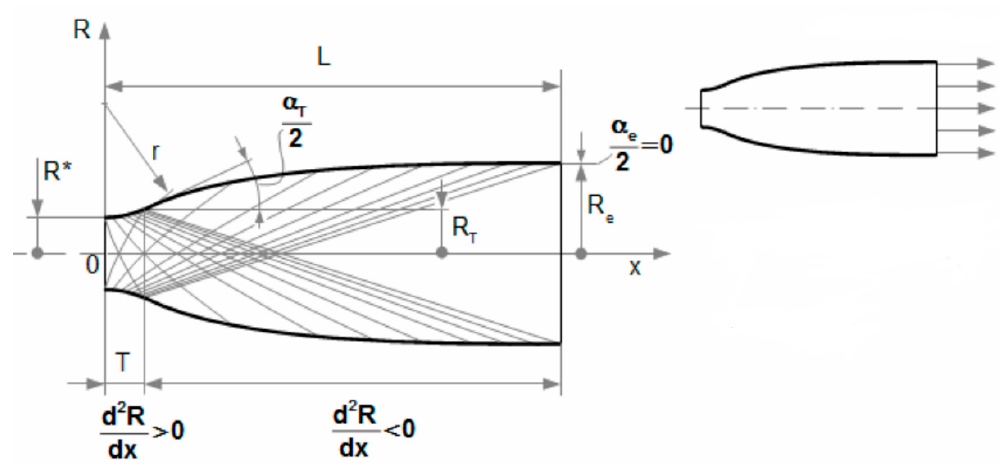
Figure 6. Laval nozzle—characteristic method. Reprinted from ref. [26]. Figure 7. Laval nozzle—Bell nozzle. Reprinted from ref. [26]. (cid:3436)𝑑𝑟 𝑑𝑥(cid:3440) (cid:3047) = tan 𝛼 (cid:2869) 2 , (cid:3436)𝑑𝑣 𝑑𝑥(cid:3440) (cid:3032) = tan 𝛼 (cid:2870) 2 (5) Figure 8. Laval nozzle—Linear shape. Reprinted from ref. [26]. 𝐼 = 𝑡 + 𝑟 (cid:3032) − 𝑟 (cid:3047) 𝑡𝑔 𝛼 2 (6) The calculation of the gas expansion dimensions, which is based on the shape of the Laval nozzle, was determined based on the physics of the isentropic one-dimensional